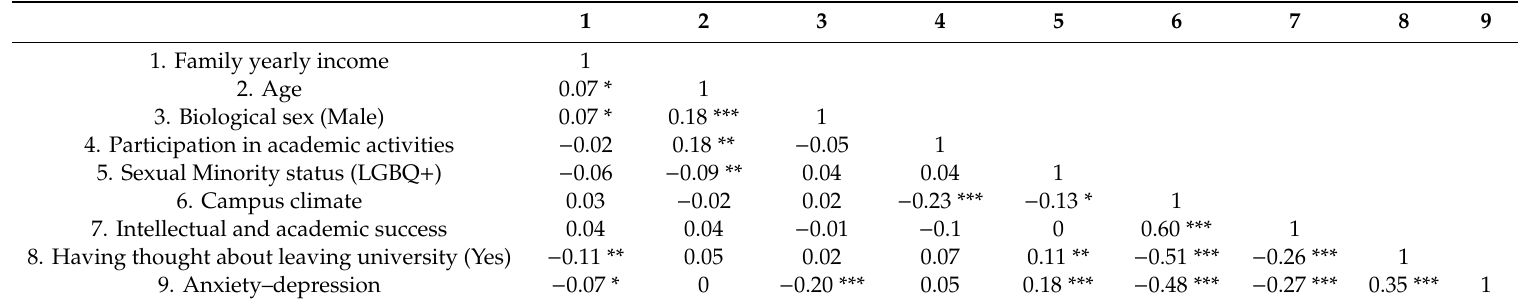
Table 2. Correlations among study’s